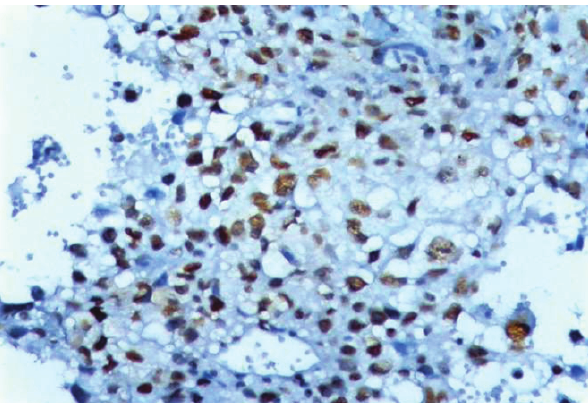
Figure 6 - Atypical osteoblastoma. Immunohistochemical detection of the p53 protein with DO7. A distinct nuclear reaction is seen the majority of the tumor cells (Case 26, immunohistochemistry, X 400)